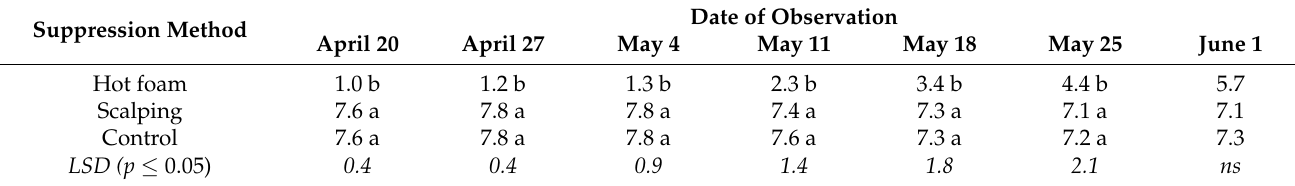
Table 6. Turf quality (1–9): mean effect of Lolium perenne suppression method.